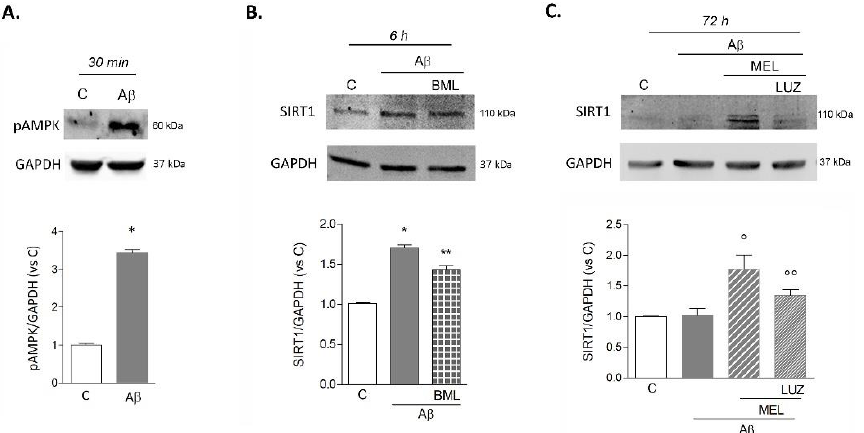
Figure 3. Involvement of pAMPK and time-course of SIRT1 expression in HMC3 cells upon A β 42 exposure. Intracellular content of pAMPK ( A ) and SIRT1 ( B , C ) was evaluated by Western blot analysis at the time points indicated. Cells were exposed to either A β 42 (0.2 µ M) alone or in combination with AMPK inhibitor BML-275 (BML, 2 µ M; B ), with melatonin (MEL, 1 µ M; C ) or with MEL+luzindole (LUZ, 25 µ M; C ). Representative blots are shown. Results are the mean ± SEM of 3–5 independent experiments. * p < 0.05 vs. C by Student’s t-test ( A ), * p < 0.05 vs. C, ** p < 0.05 vs. A β ( B ); ◦ p < 0.05 vs. C and A β , ◦◦ p < 0.05 vs. A β +MEL ( C ) by one-way ANOVA followed by Newman Keuls test for significance.